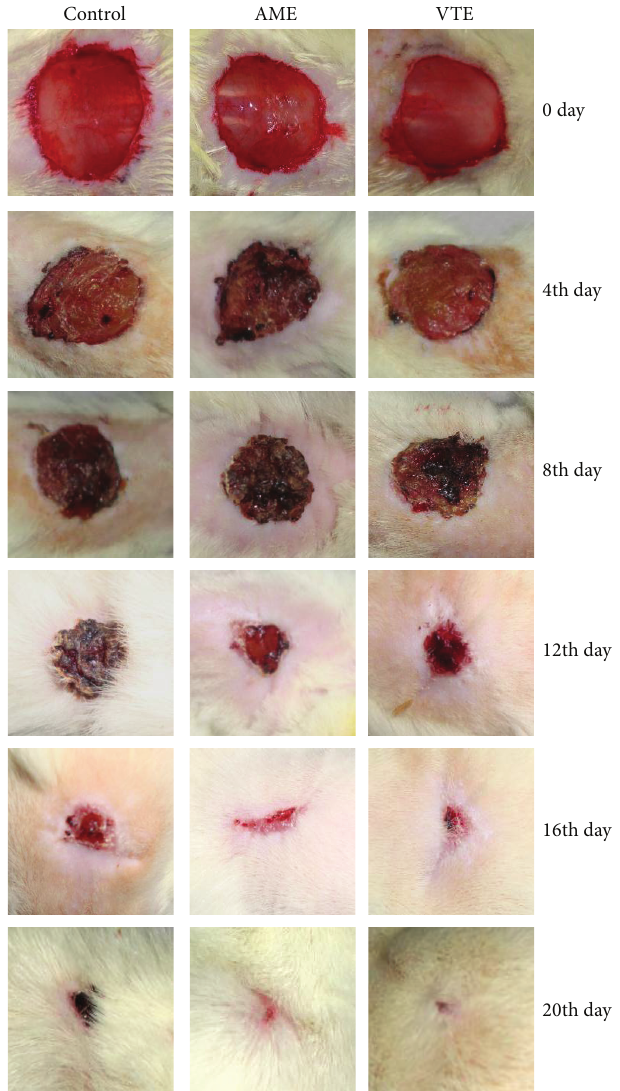
Figure 2: Photographic representation of percent wound contraction on different postexcision days of control, AME (200mg/kg) and VTE (200 mg/kg) treated rats on day 4 (Control: 9.9, AME: 20.9, VTE: 20.6), day 8 (control: 30.3, AME: 45.8, VTE: 52.4), day 12 (control: 52.9, AME: 80.9, VTE: 78.4), day 16 (control: 89.9, AME: 96.5, VTE: 99.3), and day 20 (control: 98.8, AME: 100, VTE: